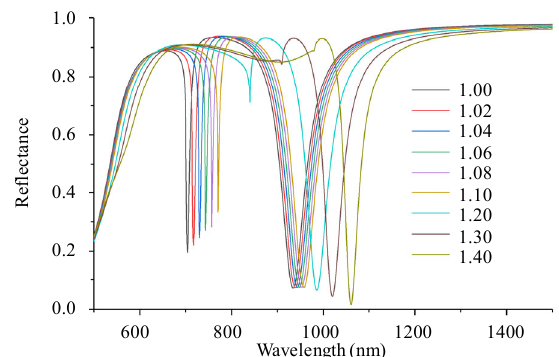
Fig. 4 Reflective spectra of the composite structure. The analyte refractive index ranges from 1.0 to 1.4 (the first six curves have refractive index steps of 0.02, and then the last four curves have refractive index steps of